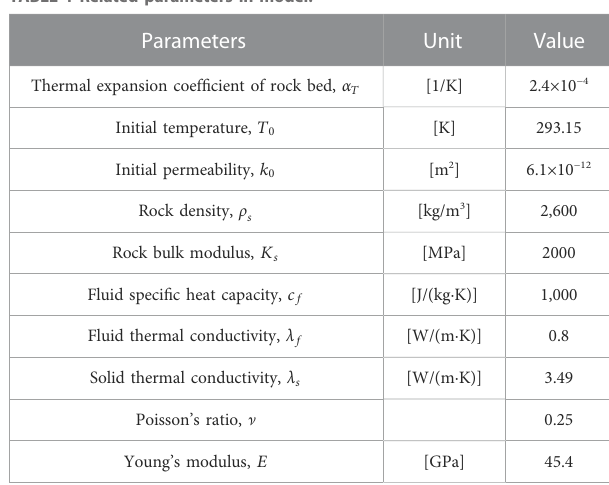
TABLE 1 Related parameters in